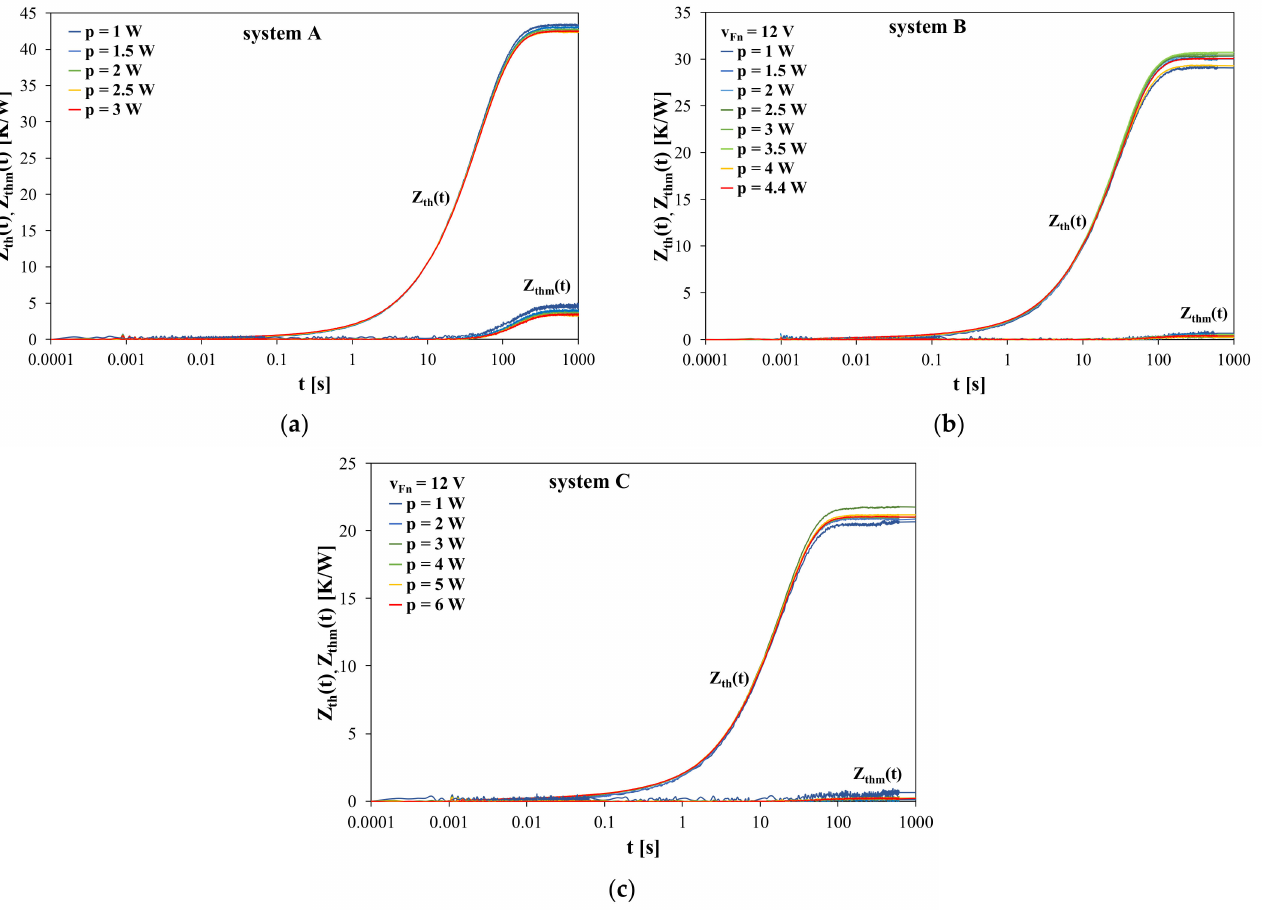
Figure 7. Self- and transfer-transient thermal impedances Z th (t) and Z thm (t) of the investigated MOSFETs with the cooling system ( a ) A, ( b ) B and ( c ) C.